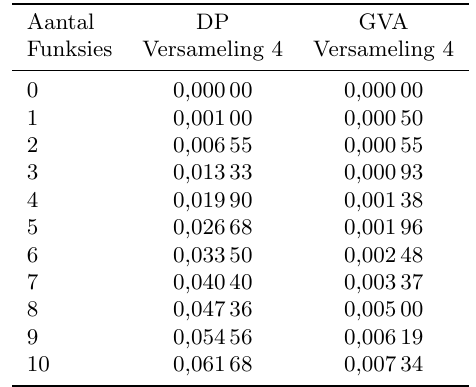
Tabel 2: Berekeningstyd met toename in die aantal kwadratiese funksies